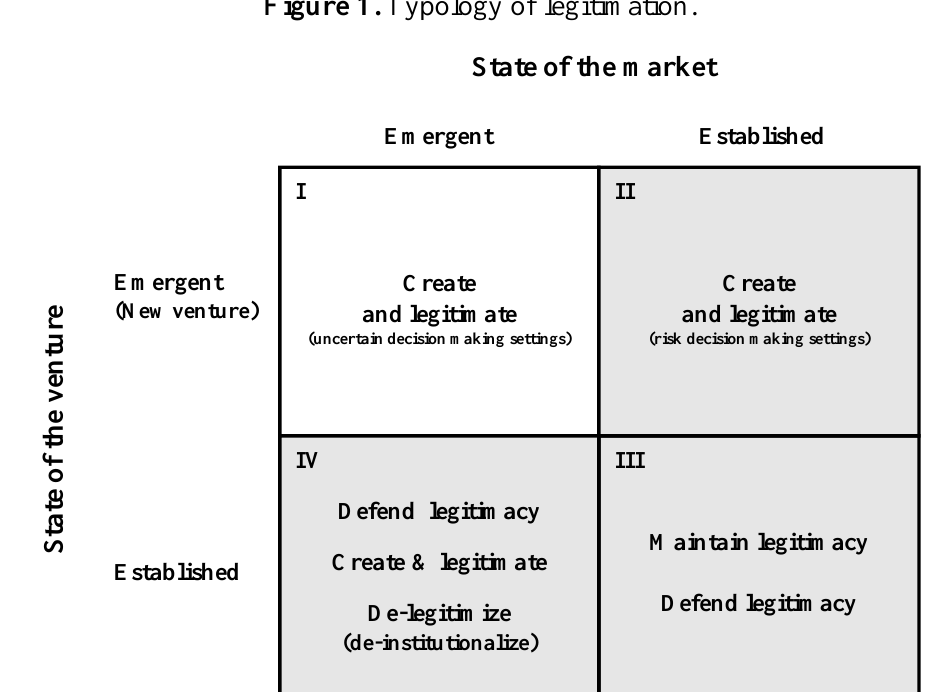
Figure 1. Typology of